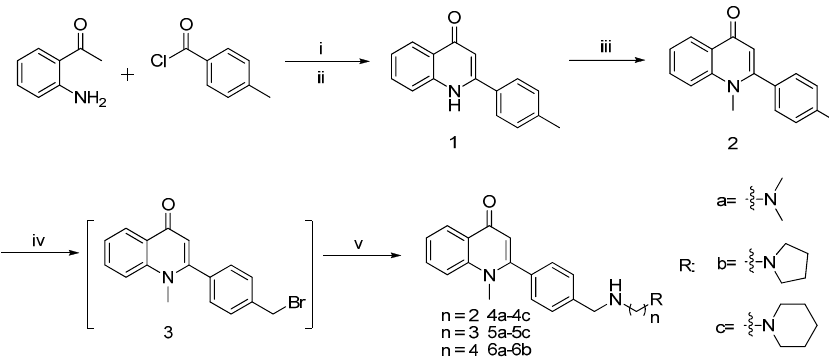
Scheme 1. Synthesis of derivatives. Reagent: (i) 4-Rbenzoyl chloride ,THF, rt; (ii) t -BuOH/ t -BuOK,